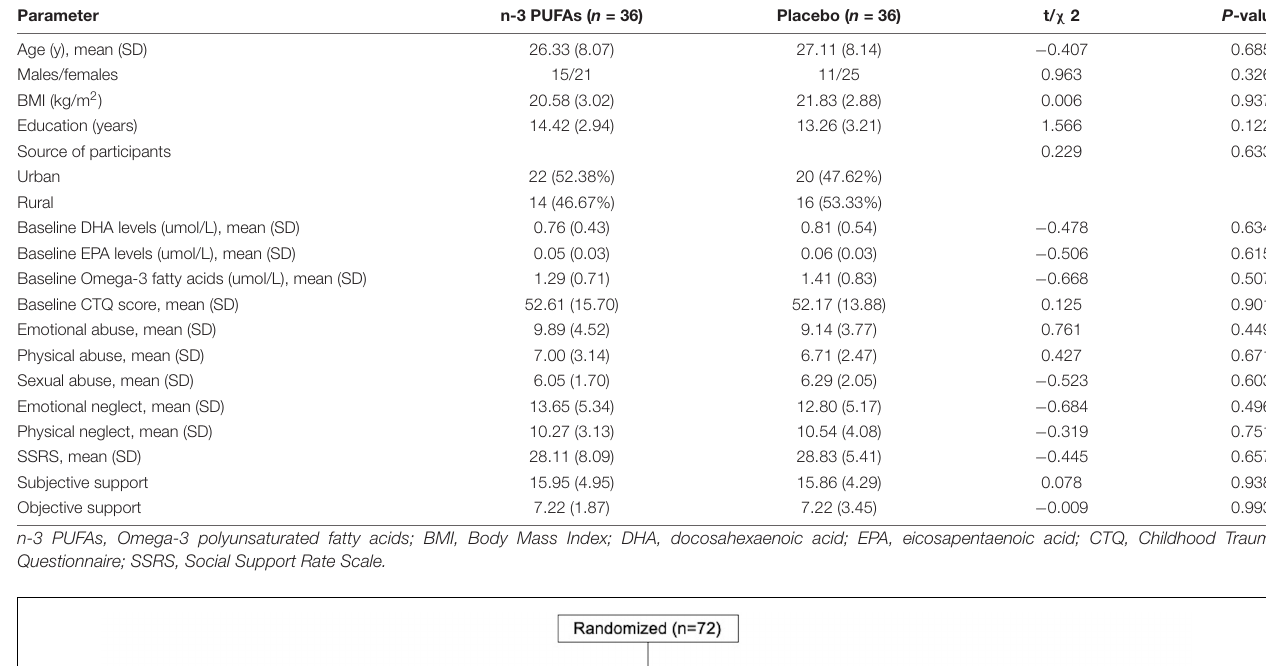
TABLE 1 | Baseline characteristics.